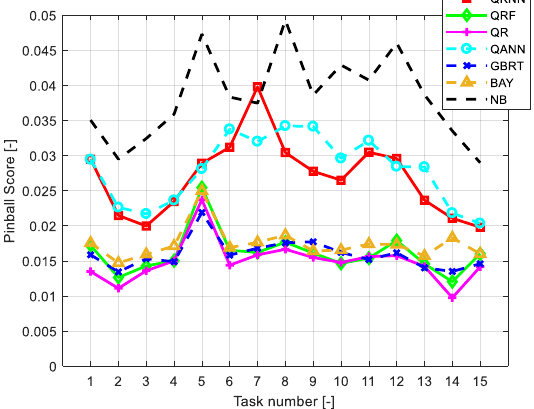
Figure 4. Pinball Score values of individual forecasts for zone 3.